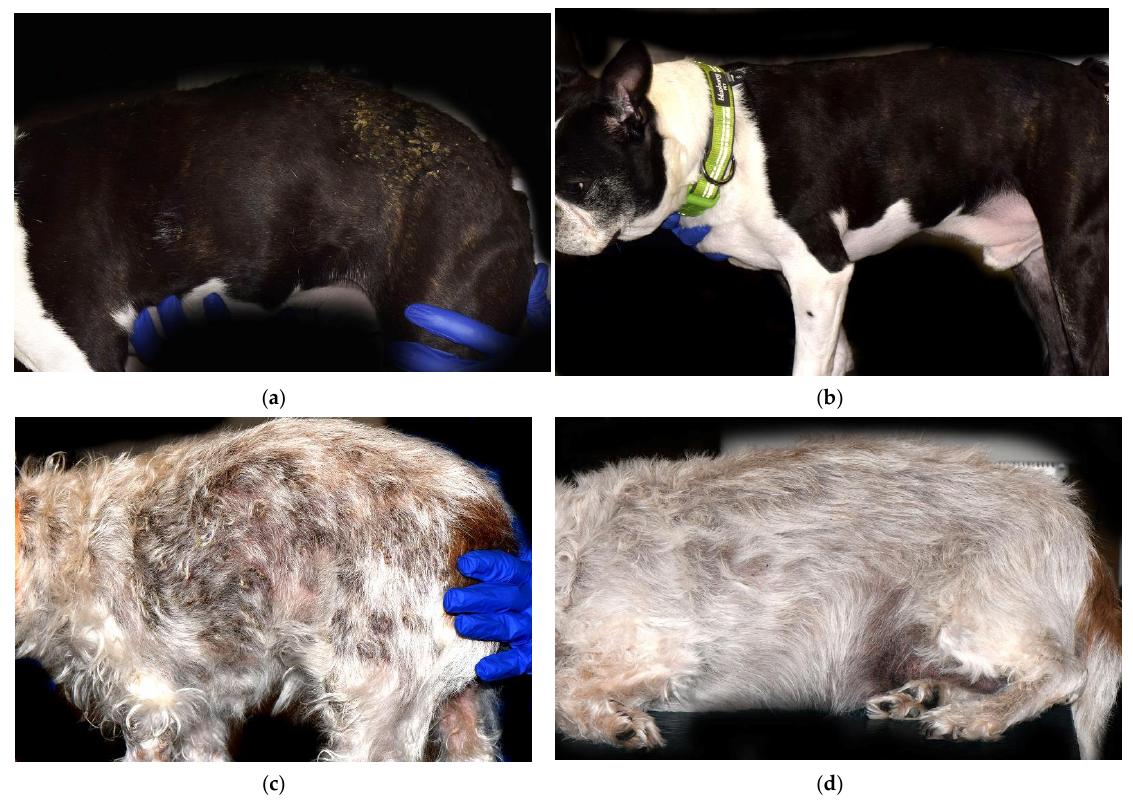
Figure 1. Clinical presentation of two dogs with PF before and after treatment with combined GC and modified oral ciclosporin (Atopica; Elanco, Greenfield, IN, USA). ( a , b ) Dog 2 on Day 0 ( a ) and on Day 56 ( b ) after Atopica and GC administration, in complete remission (CR). On Day 0 ( a ), diffuse hypotrichosis and moderate erythema over the lateral thorax and hip with multifocal areas of crusting. On Day 56 ( b ), multifocal areas of hypotrichosis with no active crusts. Dog 4 on Day 0 ( c ), and on Day 57 ( d ), in complete remission (CR). On Day 0 ( c ), large area of multifocal to coalescing crusting over the dorsolateral trunk and hip areas. On Day 57 ( d ), no active skin lesions of canine PF visible. Concurrent GCs were given with ciclosporin to all nine CR dogs (Dogs 1 – 9) during the induction phase. The mean dose of oral prednisone, prednisolone, and dexamethasone was 1.5 mg/kg/day (range 0.8–2.5 mg/kg/day, 6/9 dogs), 1.7 mg/kg/day (range 1.5–1.9 mg/kg/day, 2/9 dogs), and 0.1 mg/kg/day (1/9 dogs), respectively. Topical GCs (mometa-